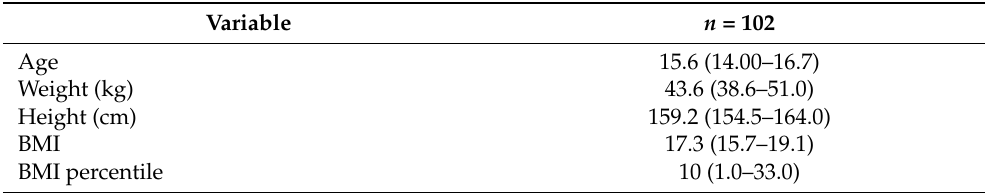
Table 1. Patients’